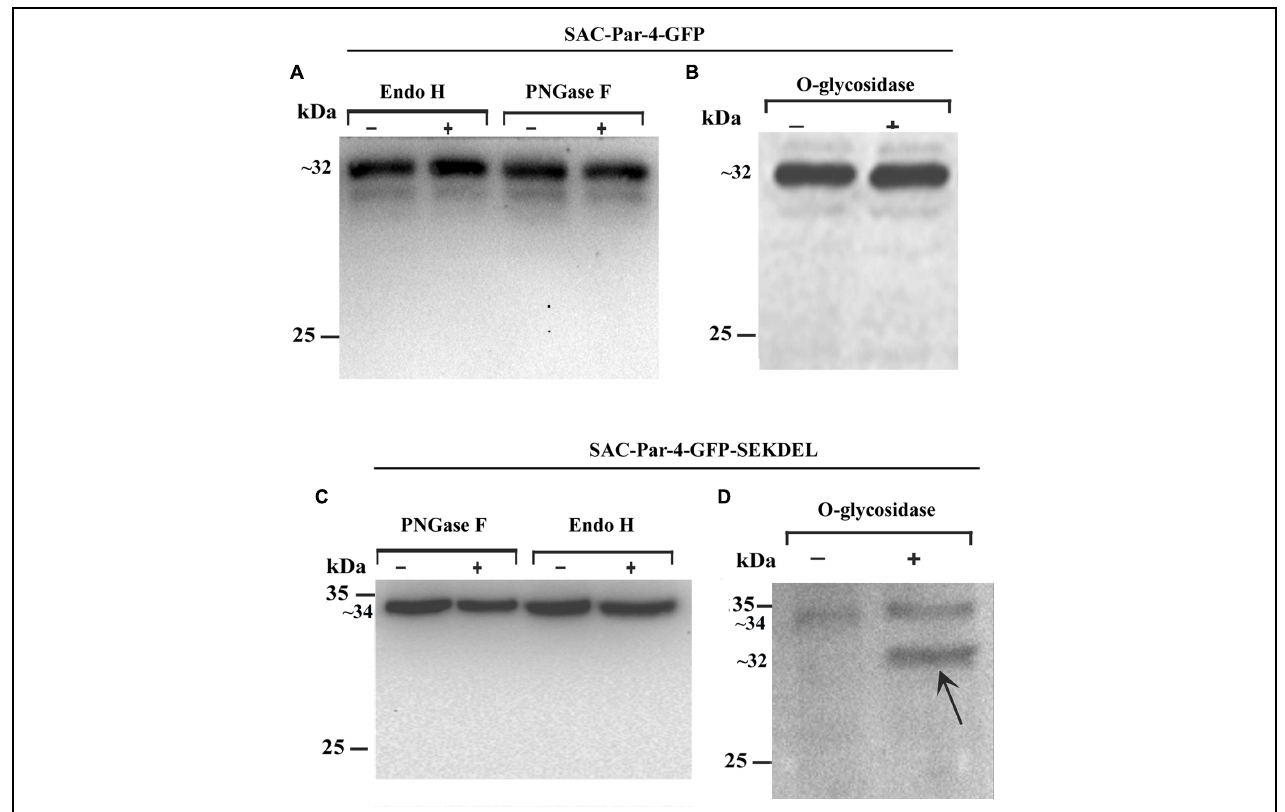
FIGURE 5 | Deglycosylation analysis of recombinant apoplast-targeted SAC-Par-4-GFP of transgenic line L3 and ER-targeted SAC-Par-4-GFP-SEKDEL of agroinfiltrated tobacco leaves protein extract. Western blot analysis of (A) SAC-Par-4-GFP protein treated with endo- β - N -acetylglucosaminidase H (Endo H) and peptide- N -glycosidase F (PNGase F); Western blot analysis of (B) O -glycosidase treated protein extract obtained from transgenic SAC-Par-4-GFP. Numbers on the left indicate the positions of protein size markers. “ + ” indicates in presence of enzymes and “–” indicates without enzymes. Western blot analysis of (C) SAC-Par-4-GFP-SEKDEL protein treated with peptide- N -glycosidase F (PNGase F) and endo- β -N-acetylglucosaminidase H (Endo H; left); Western blot analysis of (D) O -glycosidase treated protein extract obtained from transiently expressed SAC-Par-4-GFP-SEKDEL. Arrows point to